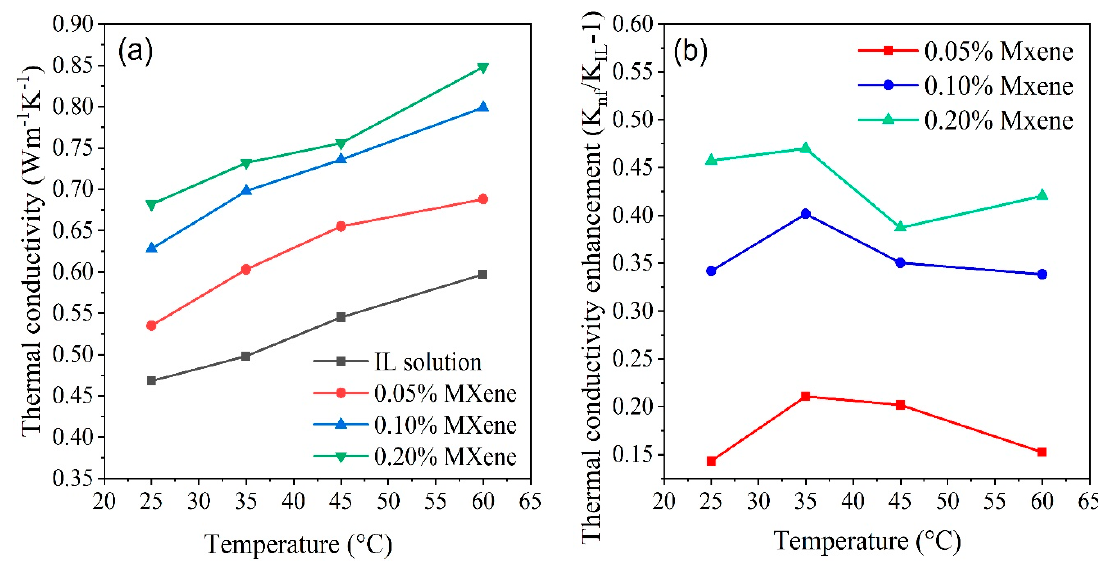
Figure 9. ( a ) Experimental values of thermal conductivity at different concentrations of Ti 3 C 2 nanosheets for varying temperatures. ( b ) Thermal conductivity enhancement ratio at different temperatures with respect to IL+ water solution.